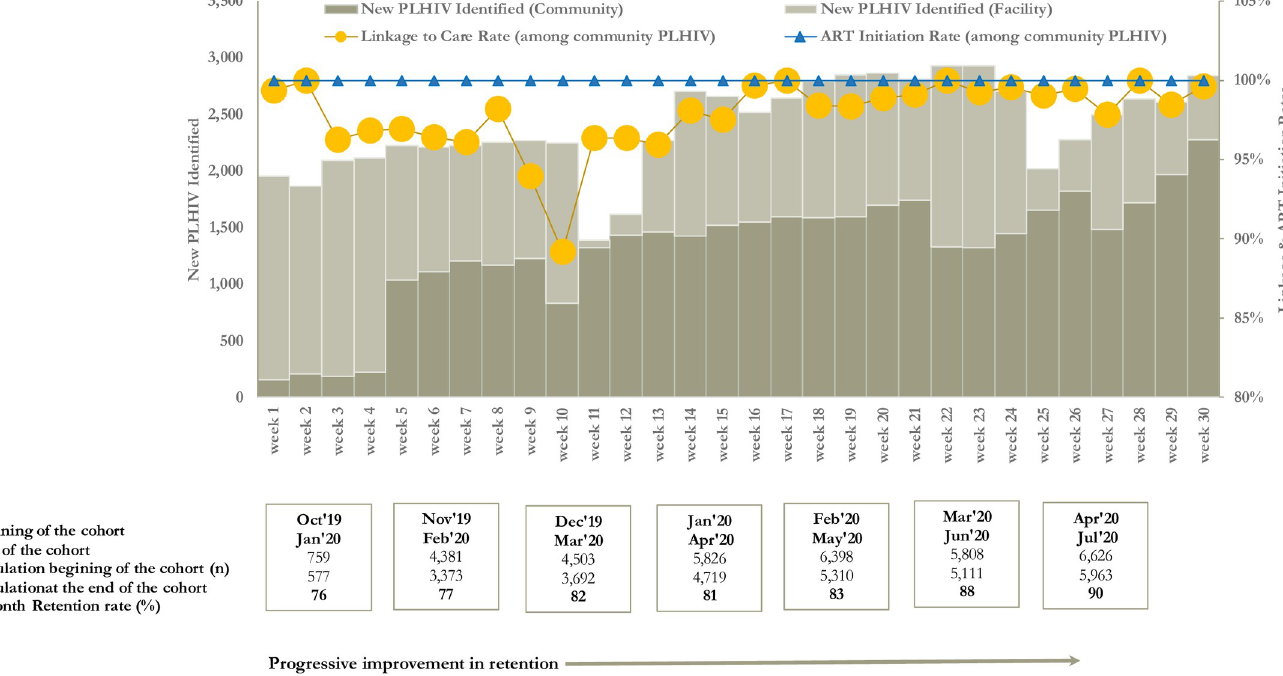
Fig 2. Linkage, Antiretroviral (ART) initiation, and retention rates during ART Surge, Nigeria, October 2019 –May 2020. Abbreviations: PLHIV–People Living with HIV; ART–Antiretroviral Therapy; HTS–HIV Testing Service.